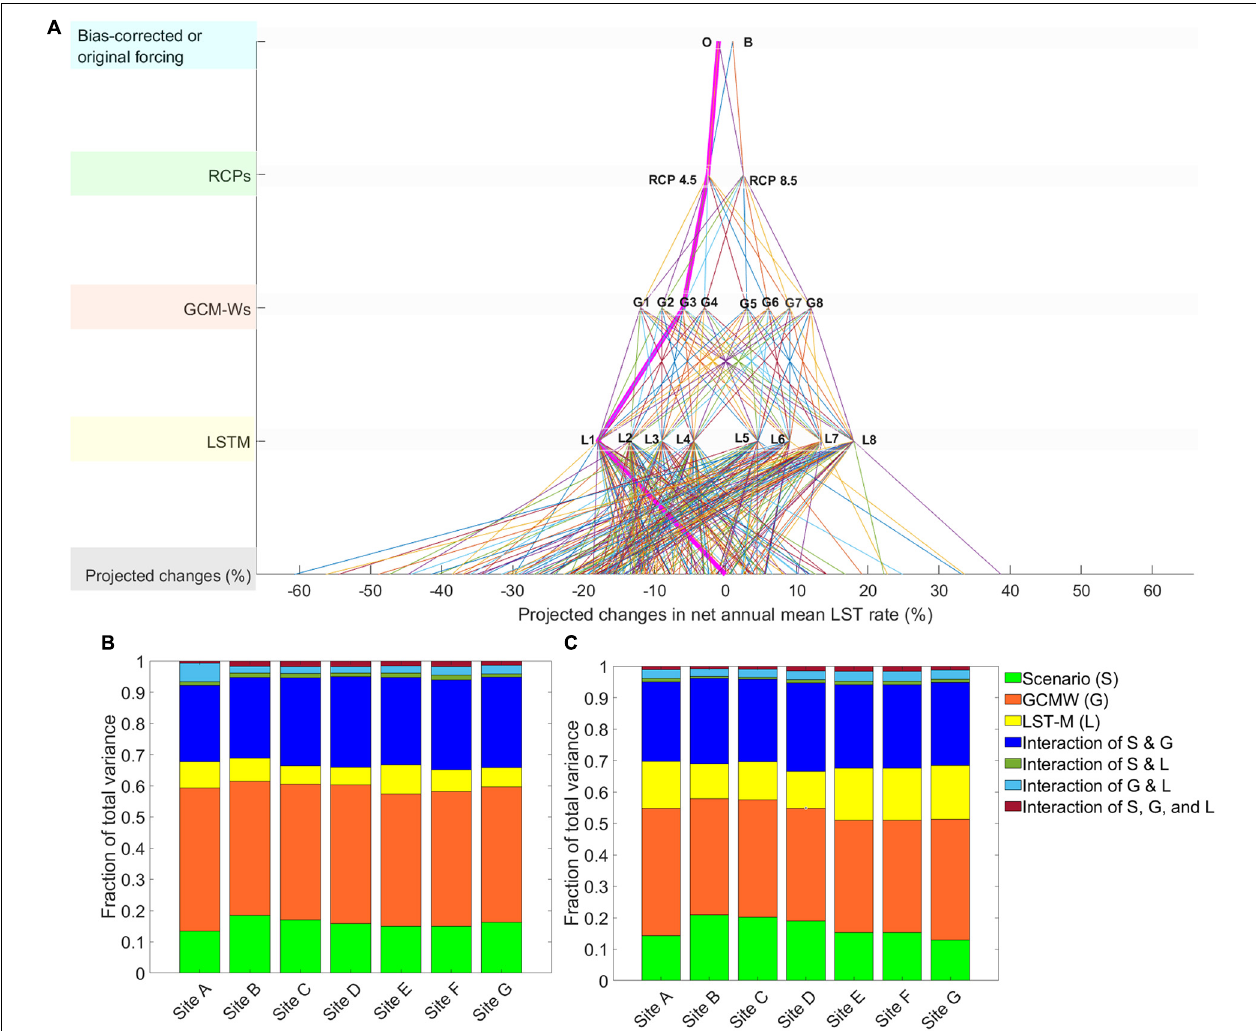
FIGURE 10 | Quantification of uncertainty contribution; (A) Cascade of uncertainty in the projected changes in net annual mean LST rate at site G; Decomposition of the total uncertainty at all sites, associated with using (B) the original and (C) the bias corrected forcing